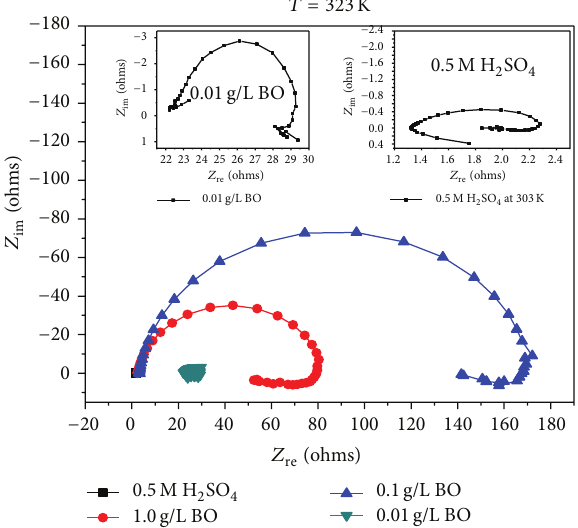
Figure 9: Nyquist plot for time effect of pipeline steel in 0.5 M H 2 SO 4 with and without different concentrations of Brassica oler- acea extract for six